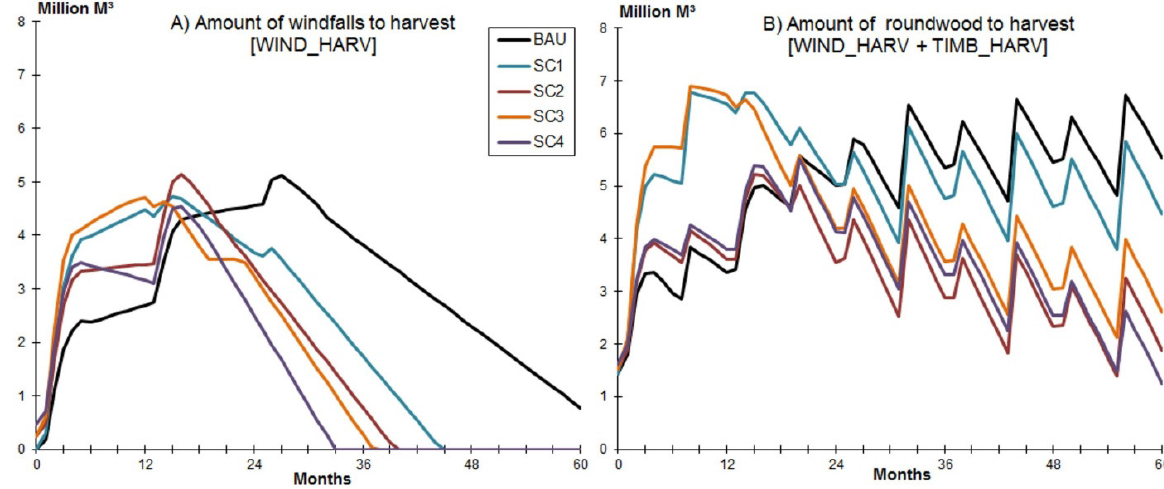
Figure 8. Levels of stocks (million m 3 ) for business-as-usual (BAU) and crisis scenarios (SC1 to